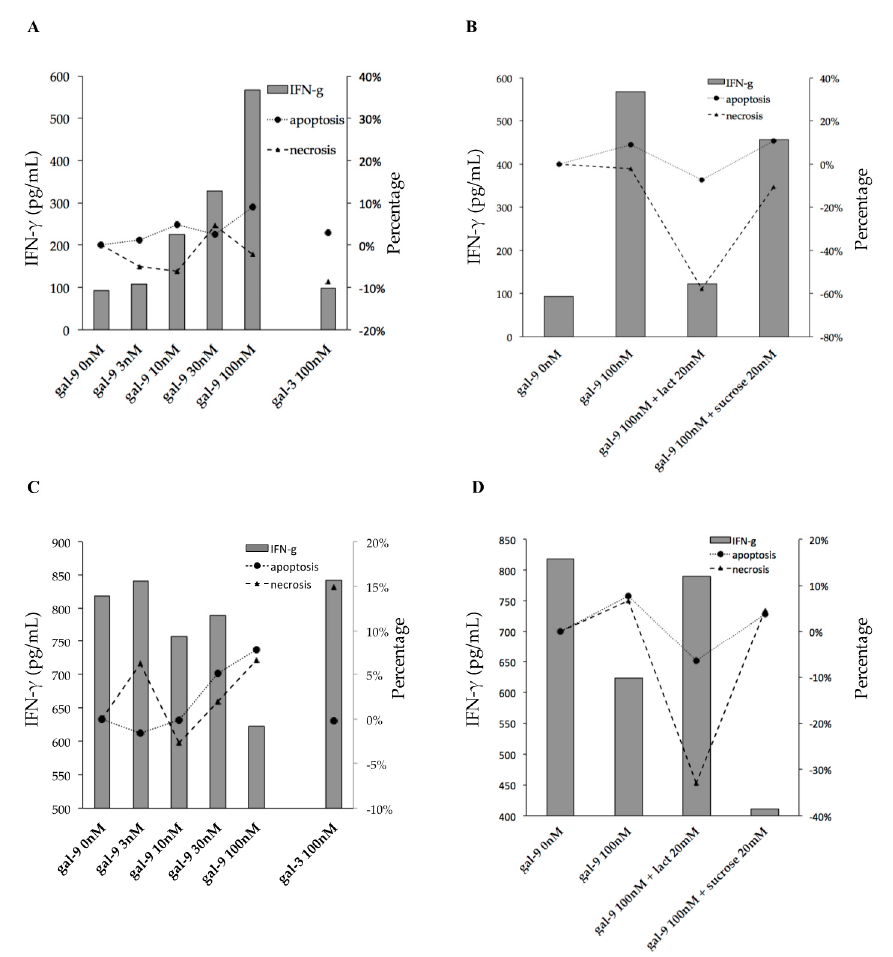
Figure 6. IFN- γ secretion, apoptosis, and necrosis in TB antigen-stimulated PFC cultures treated with Gal-9. ( A , B ) ESAT-6/CFP-10 stimulation; ( C , D ) PPD stimulation.